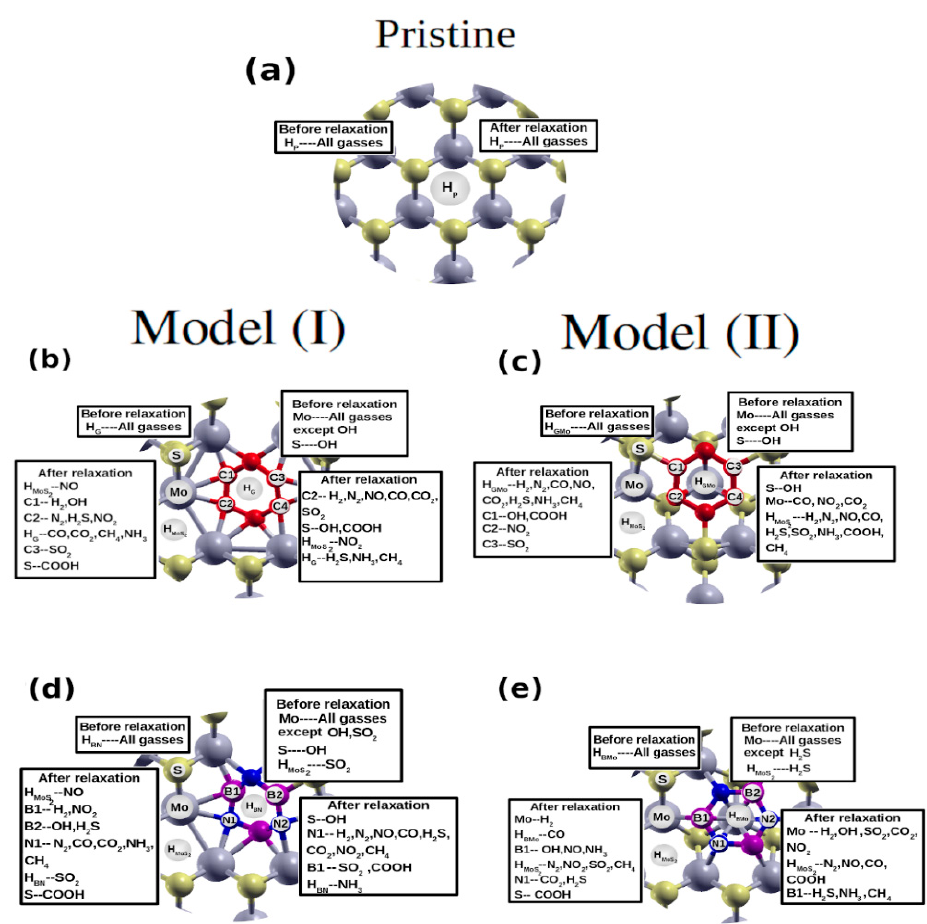
Figure 3. The positions of the adsorbed molecules before and after optimization of ( a ) pristine MoS 2 , ( b ) G@MoS 2 model I, ( c ) G@MoS 2 model II, ( d ) h-BN@MoS 2 model I, and ( e ) h-BN@MoS 2 model II.